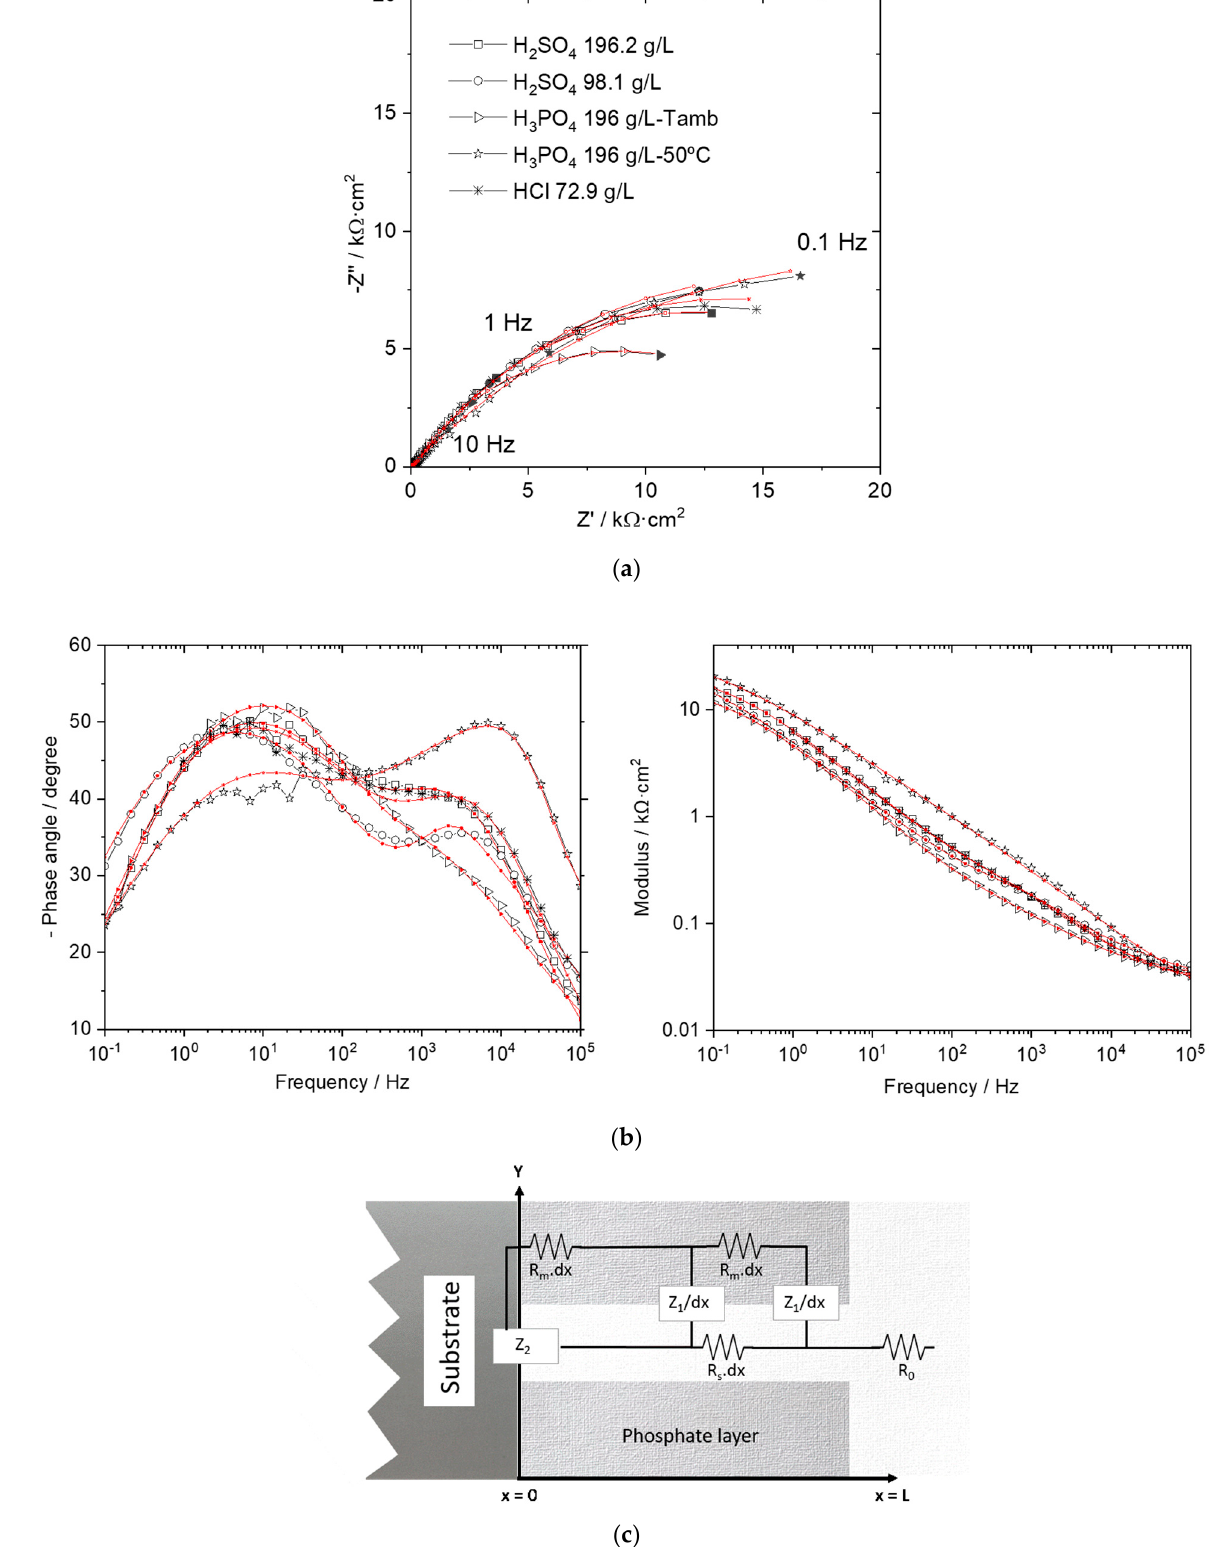
Figure 3. Impedance spectra obtained in 0.1 M Na 2 SO 4 for the phosphate layers prepared after pickling with the inorganic acids: ( a ) Nyquist plots; ( b ) Bode plots; ( c ) equivalent circuit used for modelling [3,20]. Red lines denote the fitted curves.